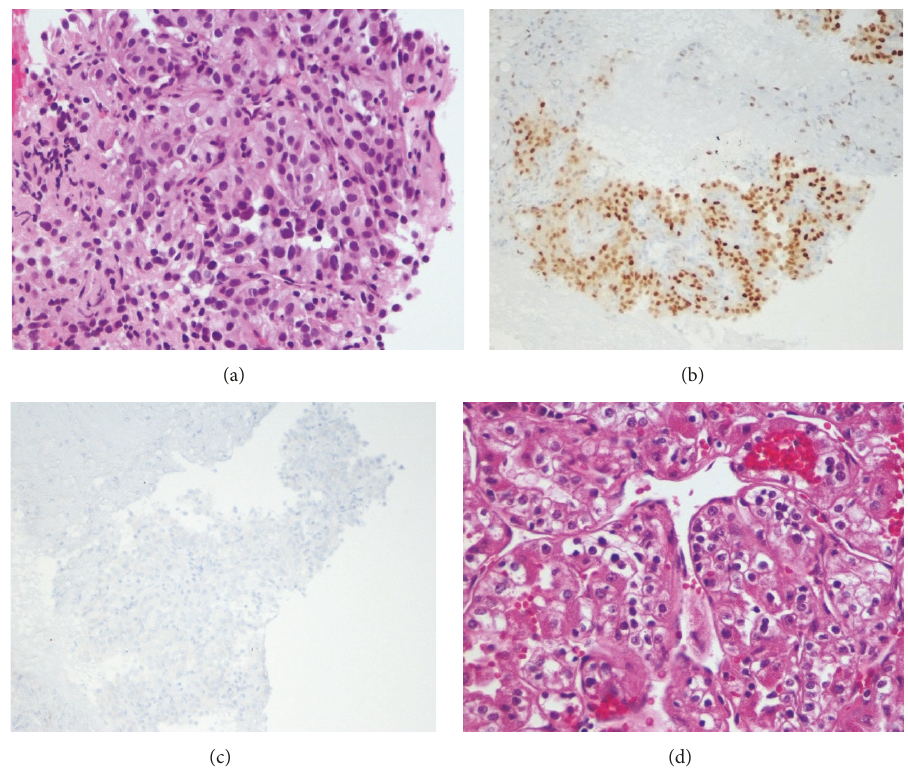
Figure 2: (a) Cell block of thyroid nodule FNA is displaying multiple nests of clear cells, which have clear to eosinophilic cytoplasm. These nests are separated by delicate vascular network and surrounded by lymphocytic infiltrate (hematoxylin-eosin stain, original magnification × 400). (b) Staining of cell block with PAX-8 shows strong nuclear positivity (PAX-8 immunohistochemistry stain, original magnification × 200). (c) Staining the cell block with thyroid transcription factor-1 (TTF-1) shows negative staining (TTF-1 immunohistochemistry stain, original magnification × 200). (d) Kidney section is showing multiple nests of clear cells, which have clear to eosinophilic cytoplasm. These nests are separated by delicate vascular network (hematoxylin-eosin stain, original magnification × 400).